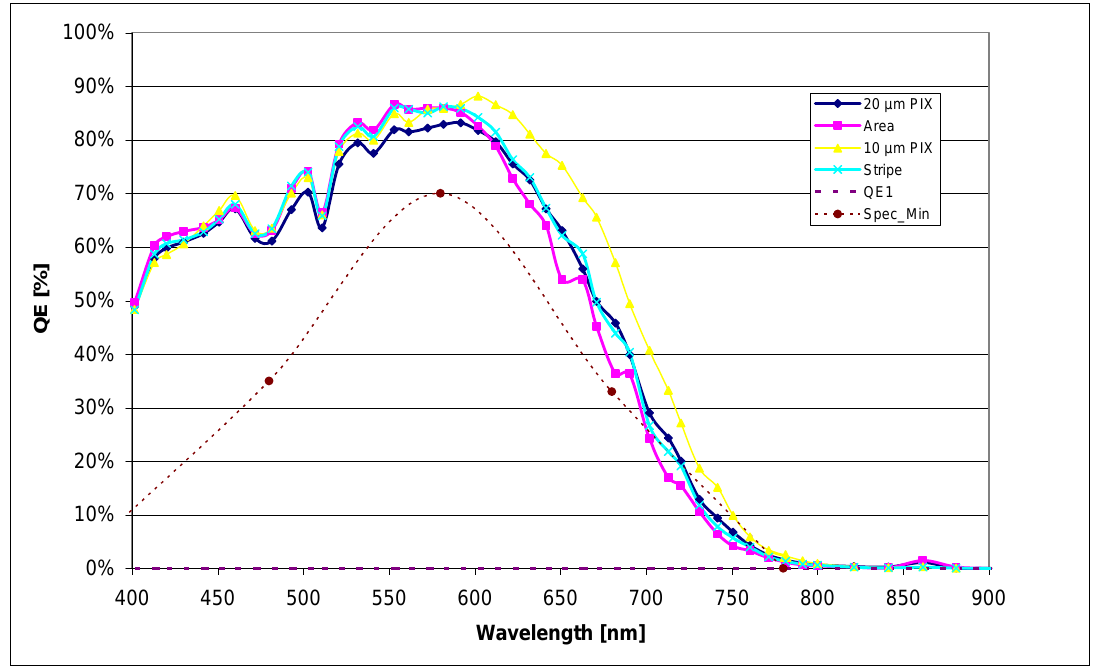
Figure 10. Quantum efficiency of a 1.5 µm thick TFC NIP-diode in relation to the diode structure. Diode area = 0.9 mm 2 @ 2 V rev. Bias